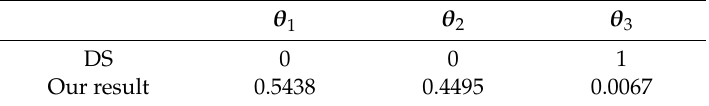
Table 1. Combination results of the two bodies of evidence m 1 and m 2 .